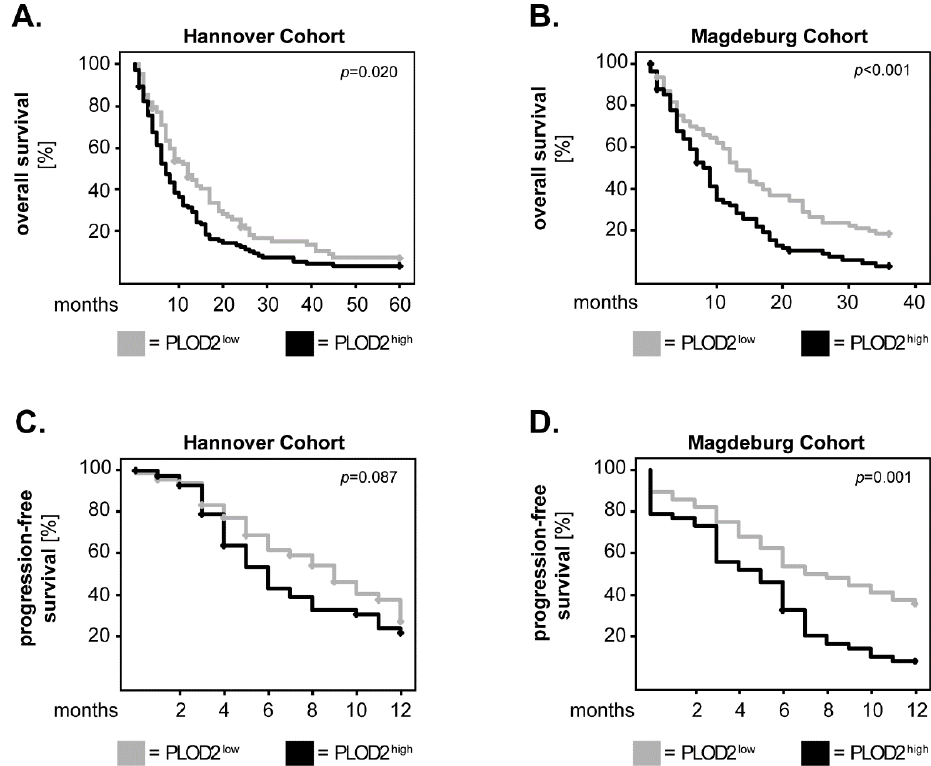
Figure 1. PLOD2 in GBM patients: univariate analysis of survival. PLOD2 expression was dichotomized into PLOD2 high and PLOD2 low according to the median-split method. Kaplan–Meier curves were plotted for the ( A ) 5-year overall survival (OS) in the Hannover cohort, ( B ) 3-year OS in the Magdeburg cohort and ( C , D ) 1-year progression-free survival (PFS) in both cohorts. The log-rank test was used for statistical analysis and the p -values are indicated in the upper-right corner of each plot.